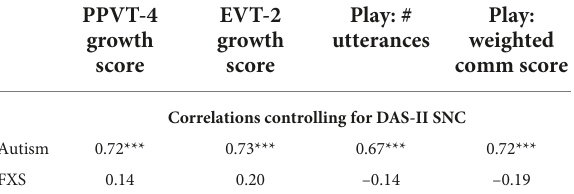
TABLE 2 Correlations between joint attention performance and language measures after controlling for non-verbal IQ. PPVT-4 EVT-2 Play: # Play: growth growth utterances weighted score score comm score